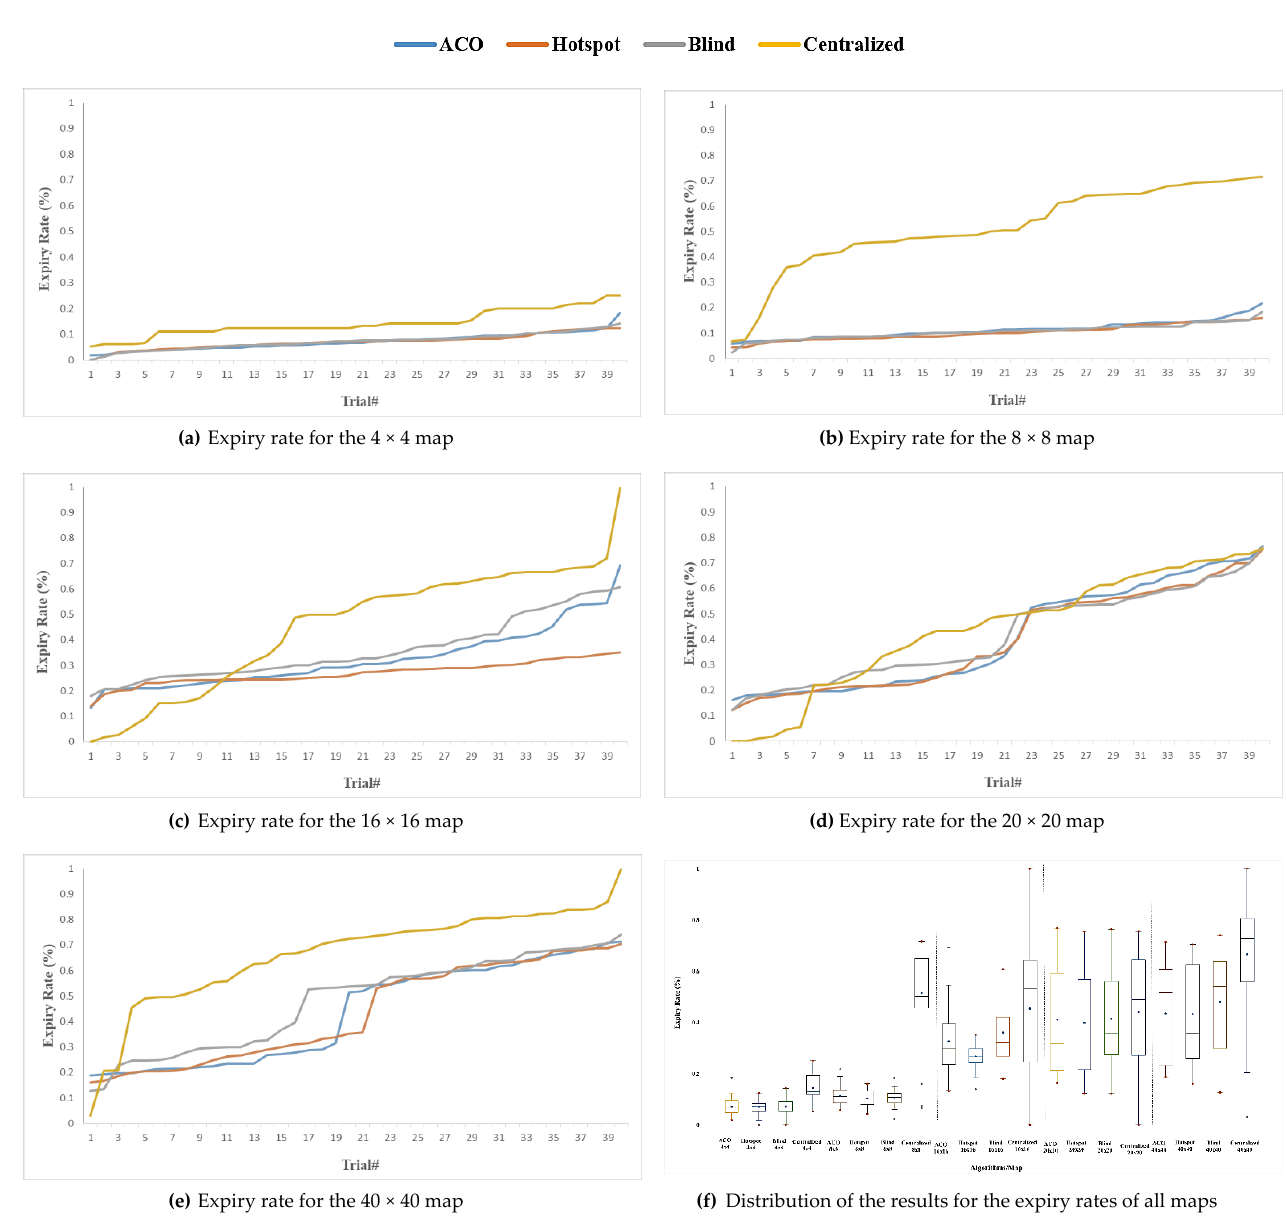
Figure 7. Flexibility results for 40 trials with different setups. The results are ordered from smallest to largest for better representation ( a – f ).